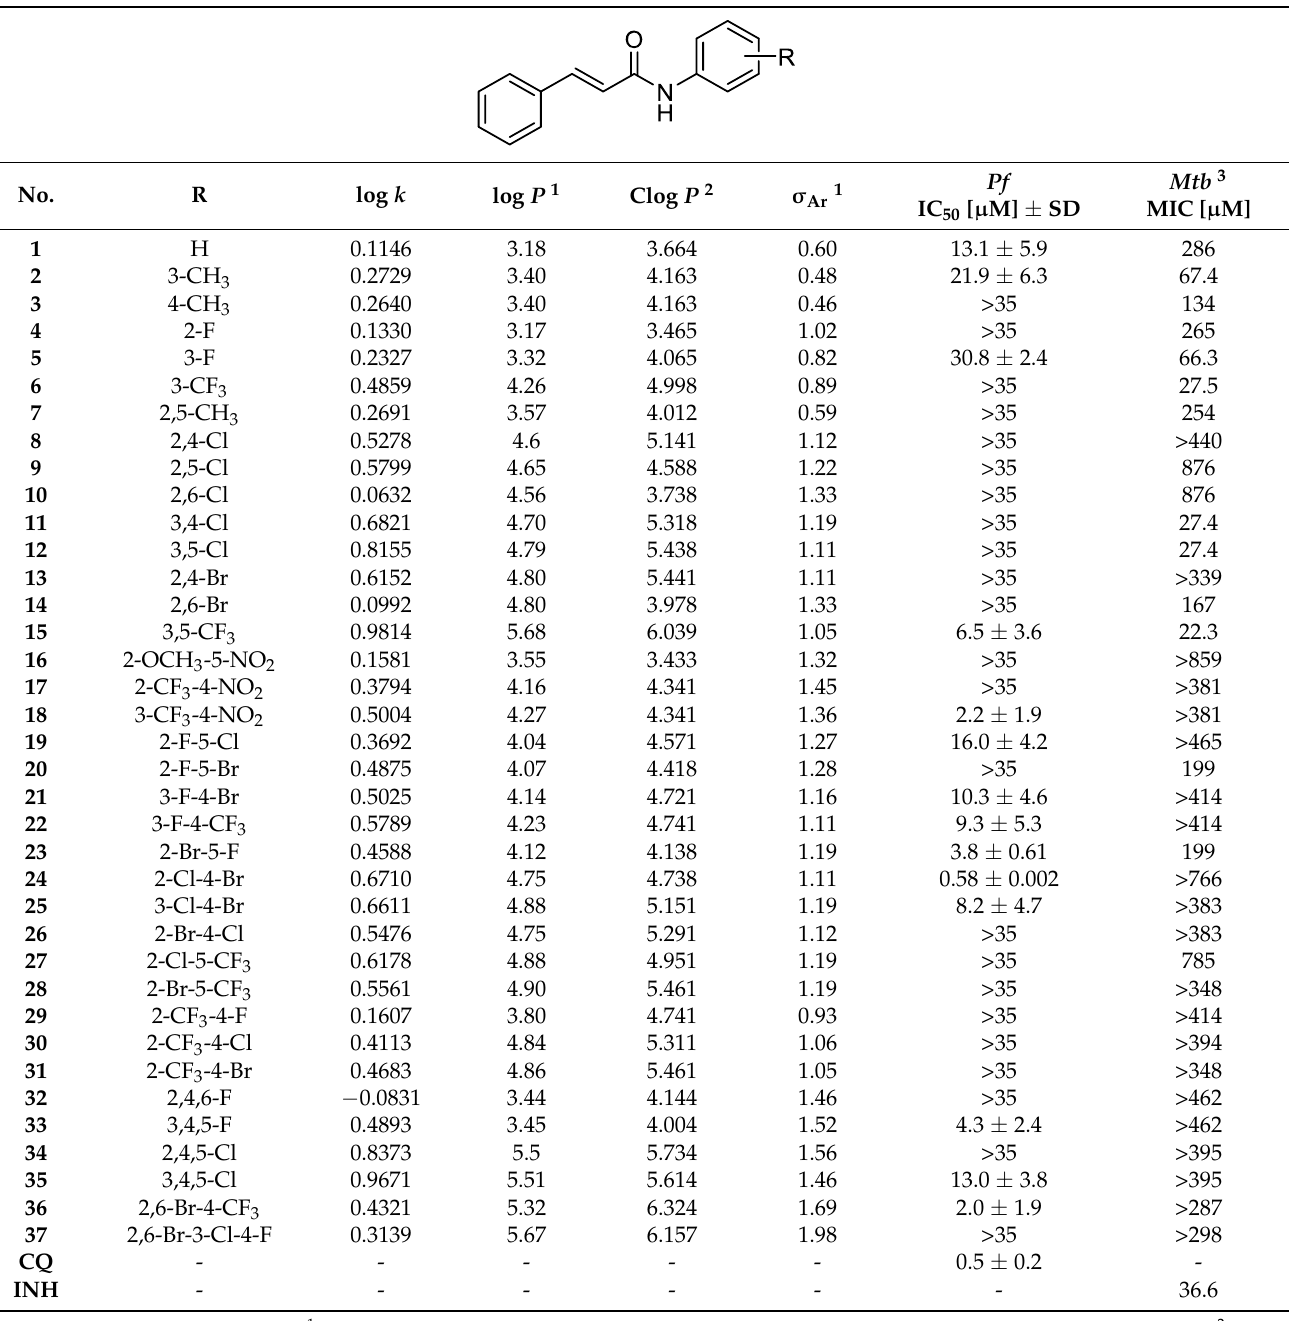
Table 1. Structures of ring-substituted (2 E )- N -aryl-3-phenylprop-2-enamides 1 – 37 , experimentally determined values of lipophilicity log k , calculated values of log P /Clog P , electronic σ parameters, in vitro antiplasmodial activity (IC 50 [µM] ± SD, n = 3) compared to chloroquine (CQ), and in